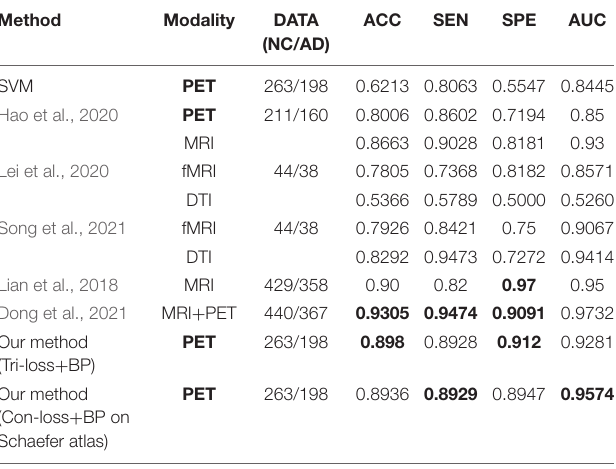
TABLE 8 | Comparison of the performance of different model algorithms in experiments for NC vs. AD classification with the related works. Method